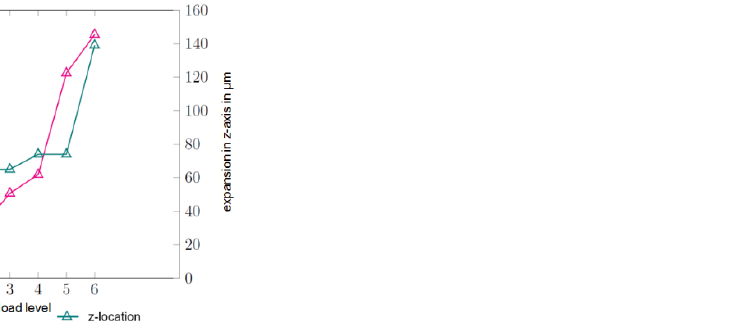
EB-PBF Ti 5553 alloy using EL = 600 J/m.